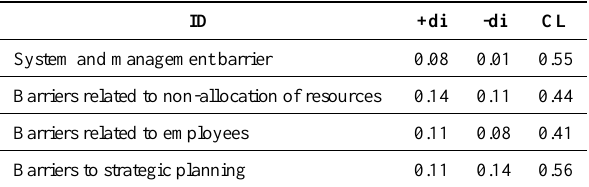
Table 10 . Prioritization of